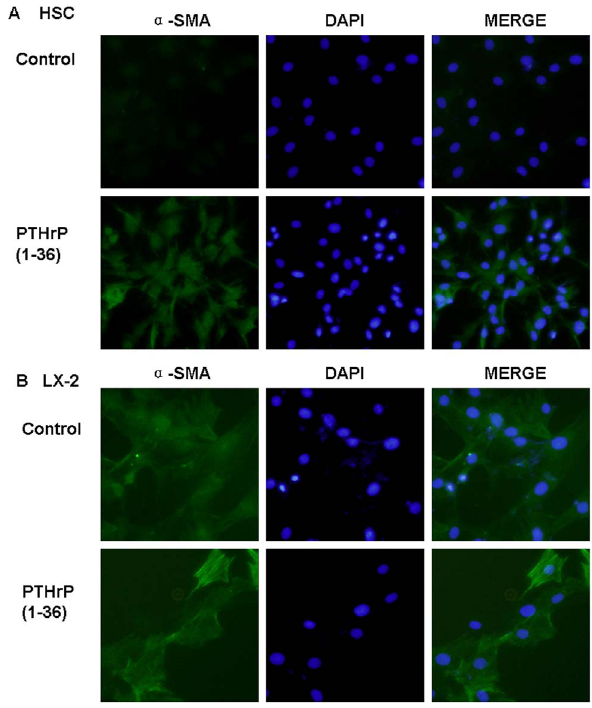
Figure 1. Alpha -SMA immunofluorescence. Alpha –SMA was detected in HSCs treated with 100 nM PTHrP(1–36) for 48 h (A), and stronger expression was found in LX-2 cells (B). Cells were counter- stained with DAPI to identify